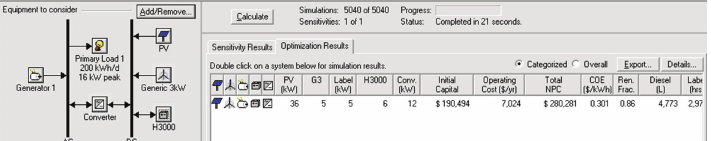
Figure 9: Proposed system by HOMER for the assumed load